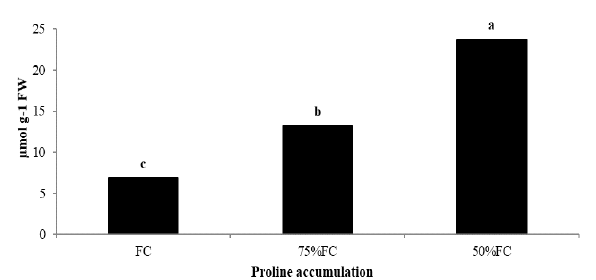
Fig. 4. Variation in proline content under water stress (75 and 50% FC) and non-stress (FC) conditions. FC: field capacity.